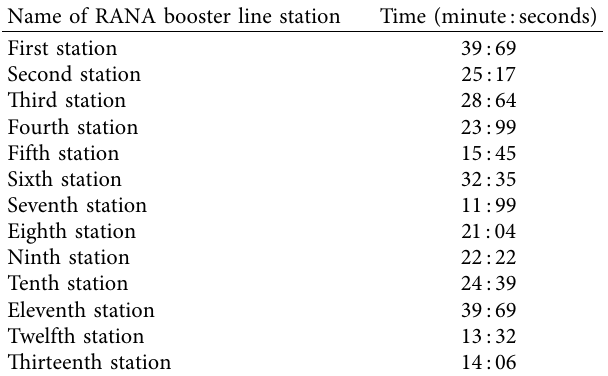
Table 5: RANA booster line. Name of RANA booster line station